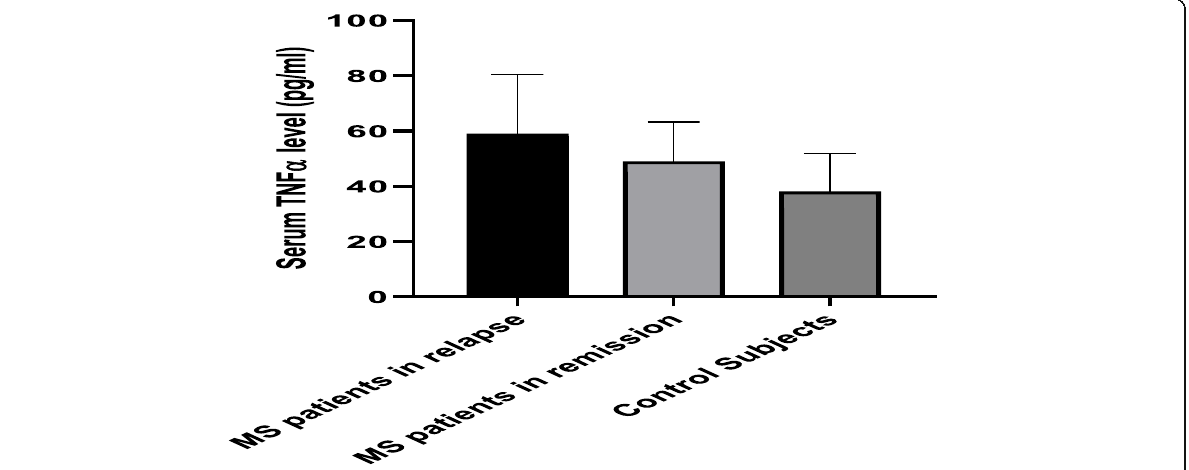
Fig. 2 Comparison of serum tumor necrosis factor alpha (TNF α ) level among the studied